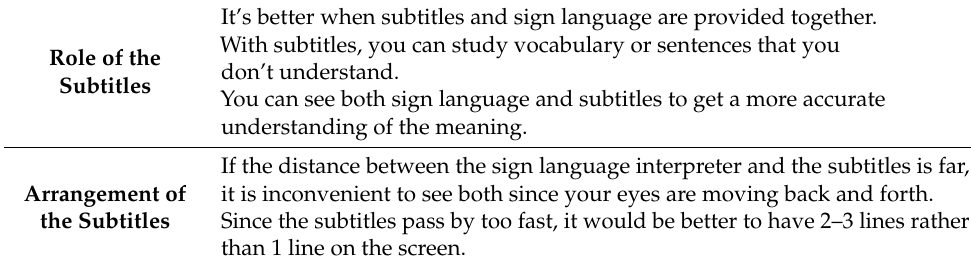
Table 9. Subjects ’ opinions on the subtitles .